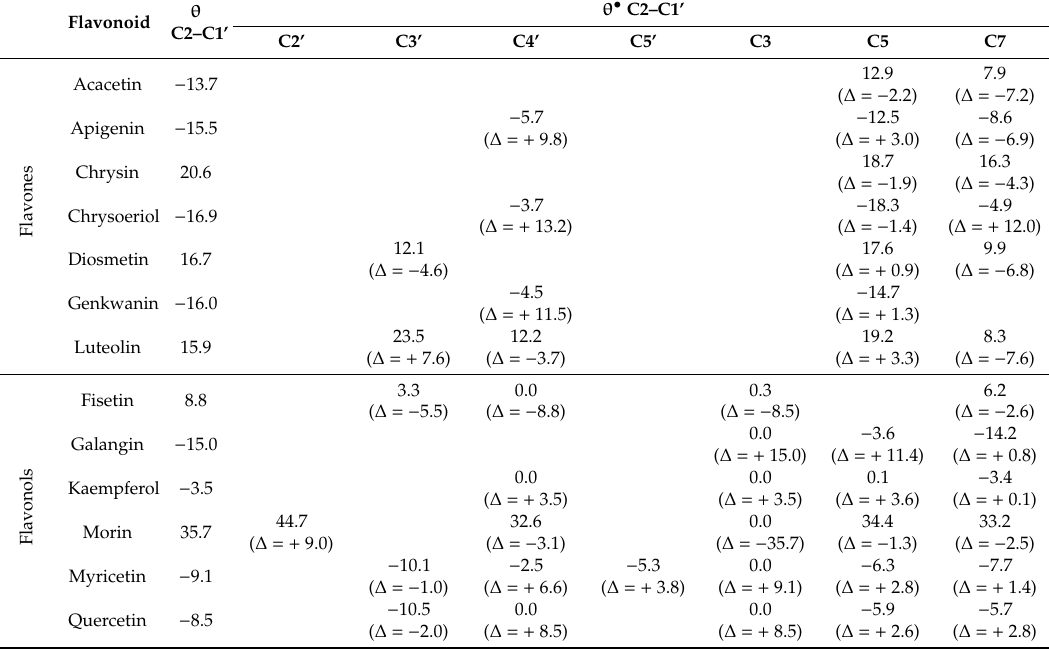
Table 2. C2–C1’ dihedral angles of molecules, their corresponding radicals and the di ff erence between them ( ∆